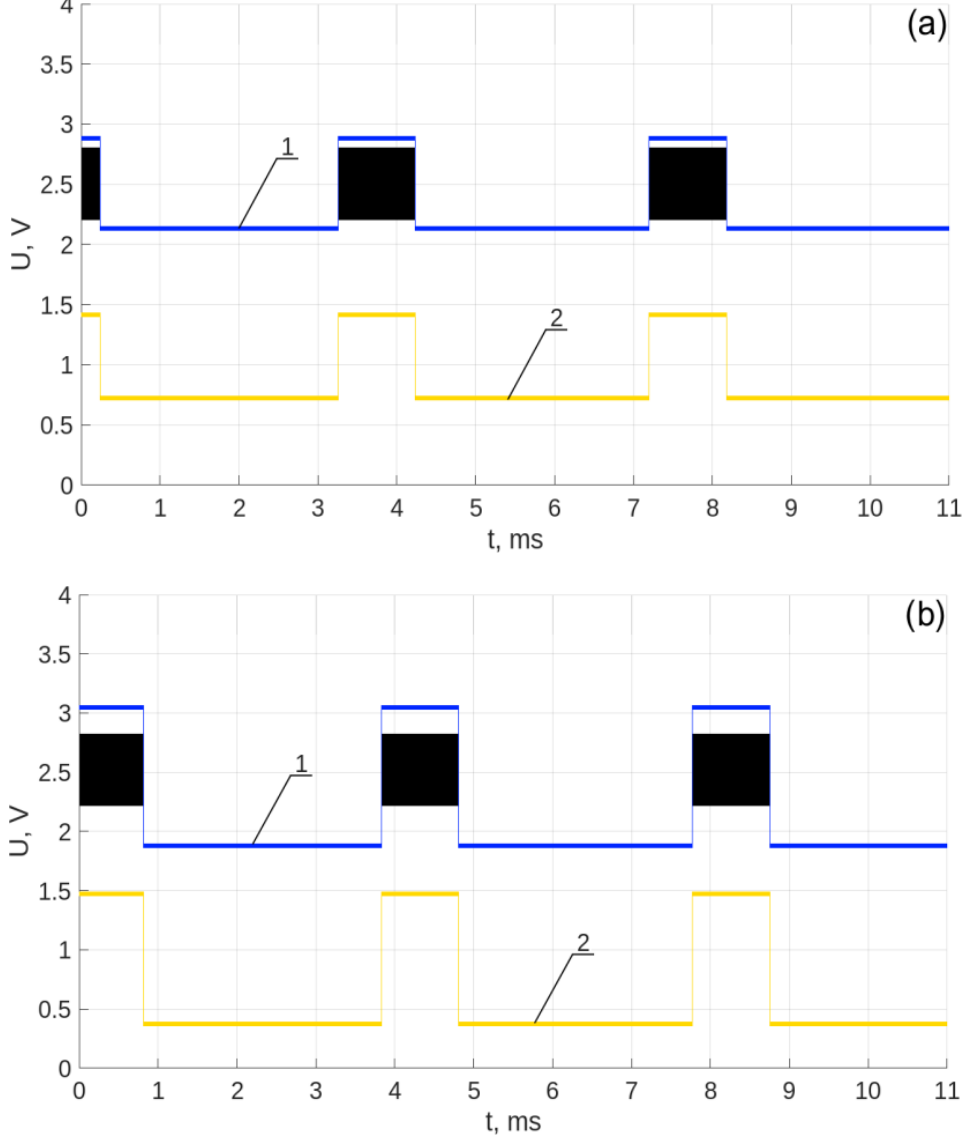
Figure 8. Rectangular pulses for transmitting digits in numbers as a sequence of command codes. Graph 1 corresponds to the signal at the input to 2. Graph 2 corresponds to the signal at output 6 for different values of L in km: ( a ) 200; ( b ) − 250.